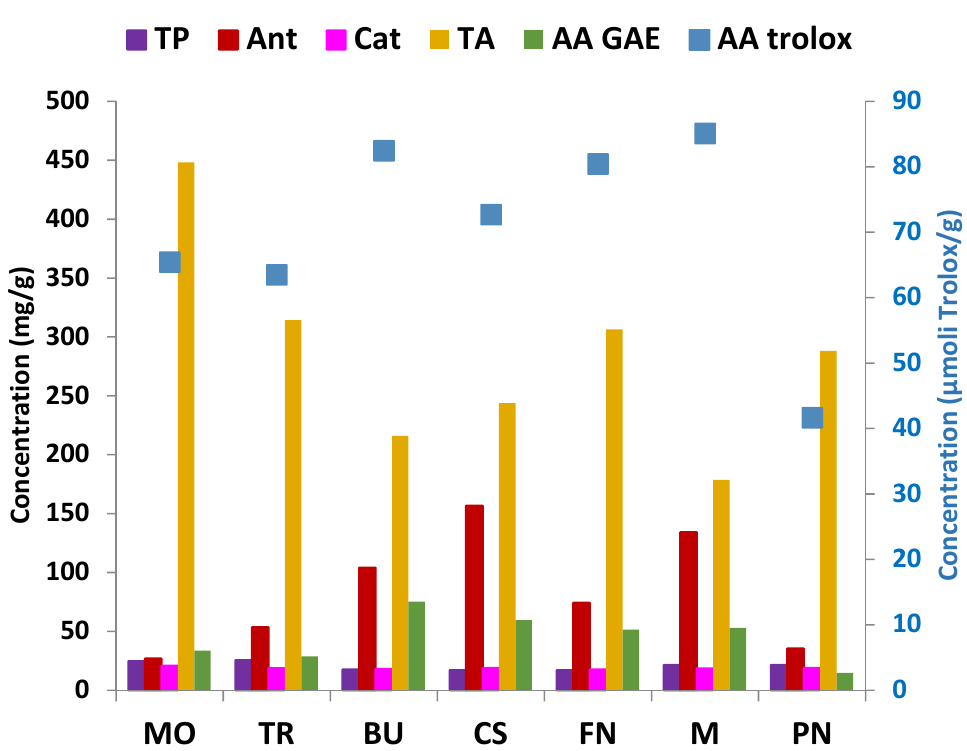
Figure 1. Bioactive properties of different grape pomace varieties (PN—Pinot Noir, M—Merlot, FN—Feteasca Neagra, CS—Cabernet Sauvignon, BU—Burgund, TR—Tamaioasa Romaneasca, MO—Muscat Ottonel).